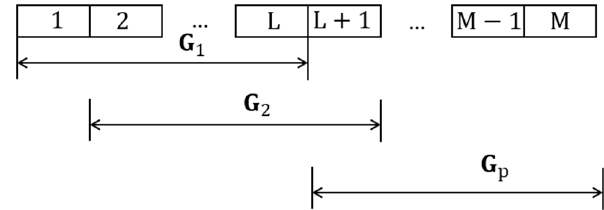
Figure 2. Schematic diagram of subaperture